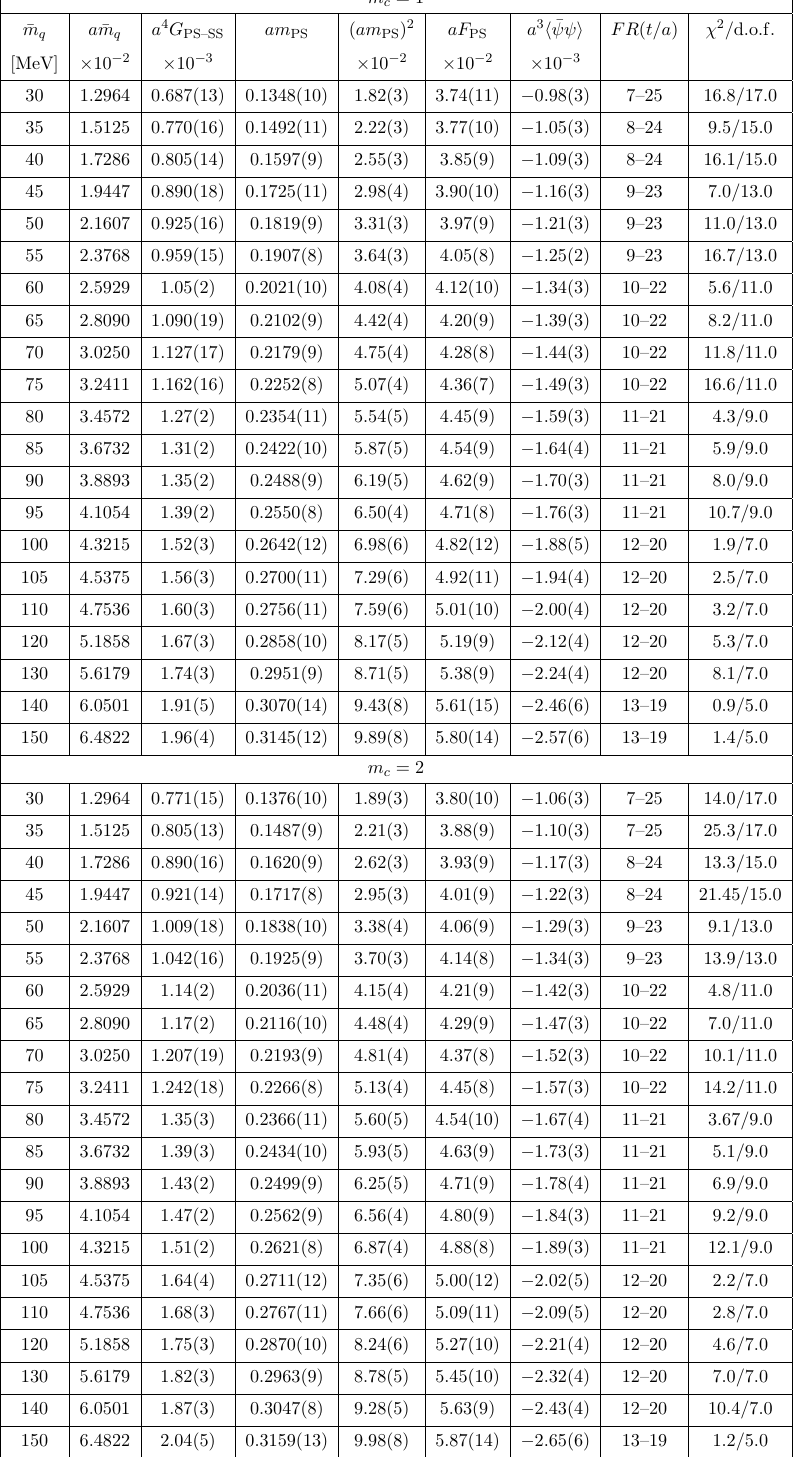
Table 25 . The (cid:12)tting results of a 4 G PS{SS and am PS together with the analytic results of the square of the pseudoscalar mass ( am PS ) 2 , decay constant aF PS , and chiral condensate a 3 h (cid:22) i . The magnetic charges of the con(cid:12)gurations are m c = 1 and m c =